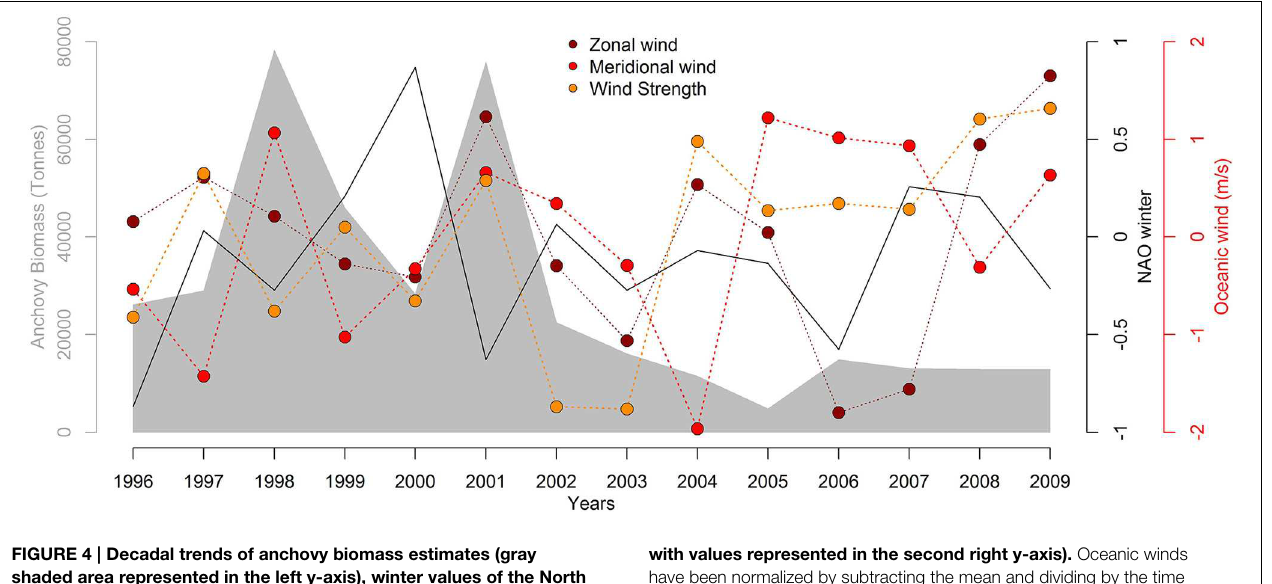
FIGURE 4 | Decadal trends of anchovy biomass estimates (gray shaded area represented in the left y-axis), winter values of the North Atlantic Oscillation index (NAO, solid black line represented in the first right y-axis) and oceanic winds (zonal, meridional, and wind strength indicated by dark blue, blue, and light blue dotted lines, respectively,